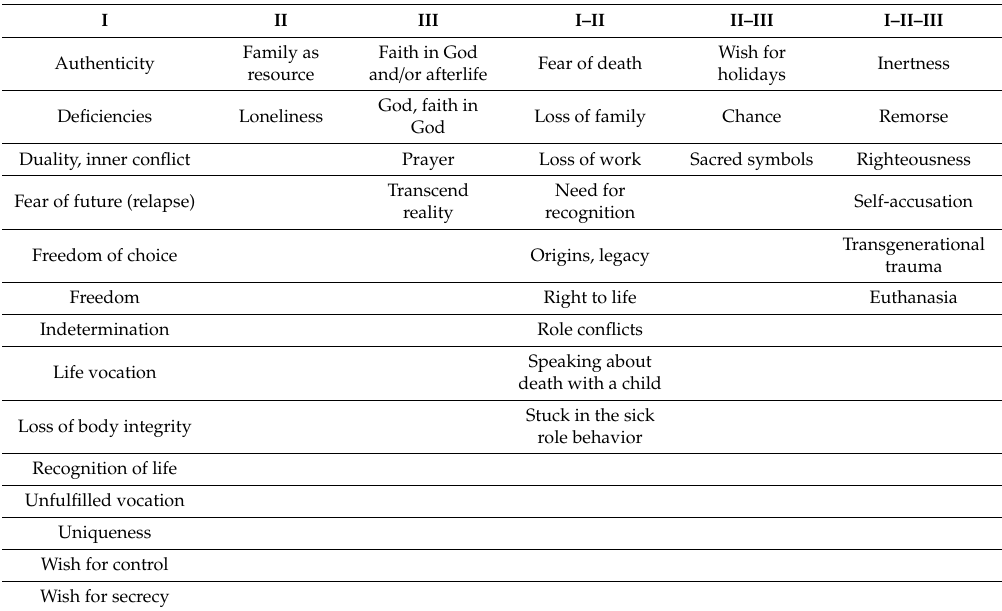
Table 4. Summary of spiritual needs and